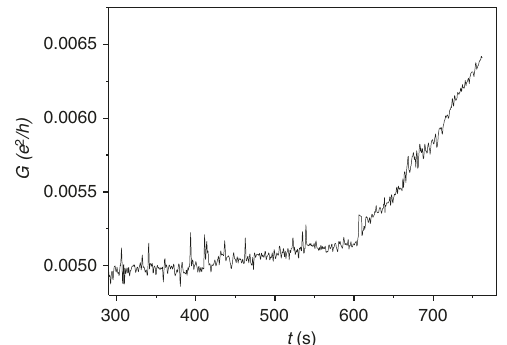
Fig. 5 Conductance measurement during electrodeposition. Dimensionless